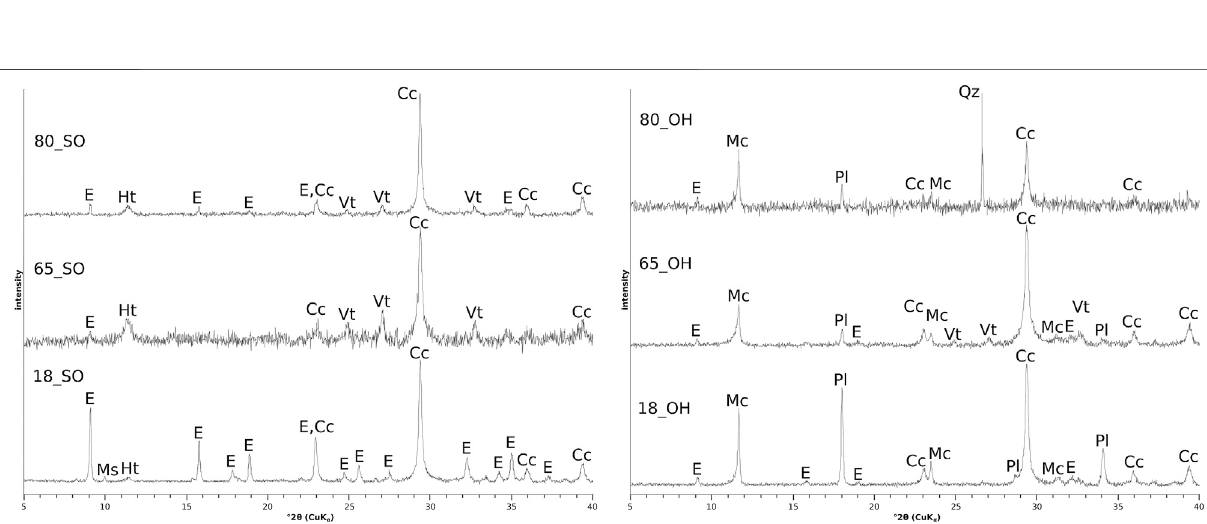
FIGURE 2 | X-ray diffractograms of the powdered surface layers of the hardened cement paste fl at prisms after storage in sodium sulfate solution (30 gl − 1 SO 2 − 4 , left) or in saturated calcium hydroxide solution (right) . E, ettringite; Cc, calcite; Ms, monosulfoaluminate; Ht, hydrotalcite; Vt, vaterite; Mc, monocarboaluminate; Pl, portlandite; Qz,